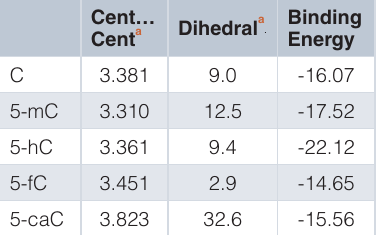
Table 2. Geometry and binding energies of stacked CG base pairs from B97-D/ def2-TZVP (Å, ° and